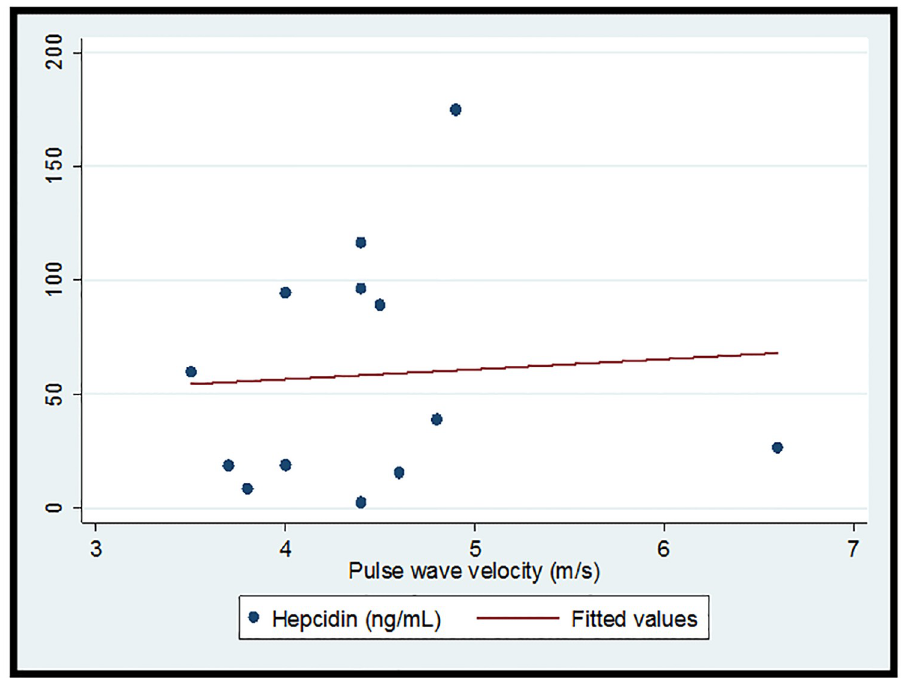
Fig 1. Correlation and linear prediction plot for hepcidin and pulse wave velocity in children with SLE. r = 0.06, p = 0.83.